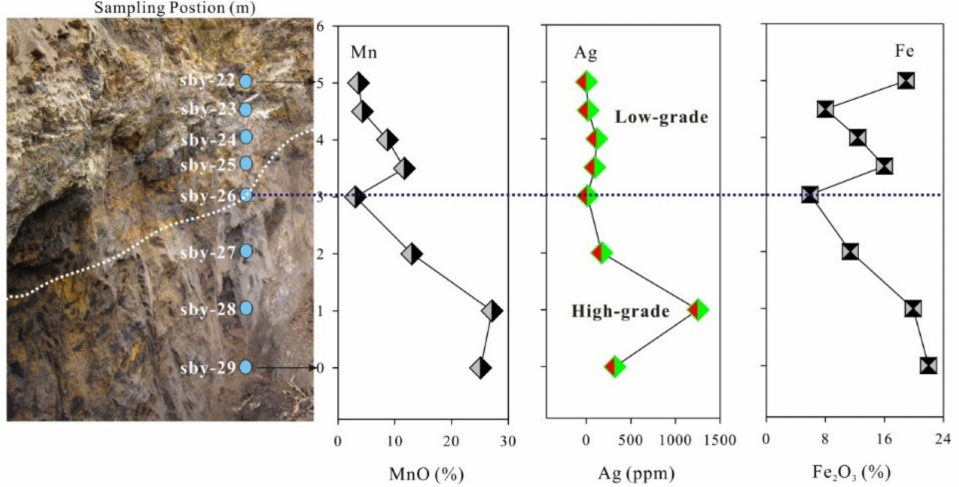
Figure 5. Elemental variation within a vertical profile from the Sanbao